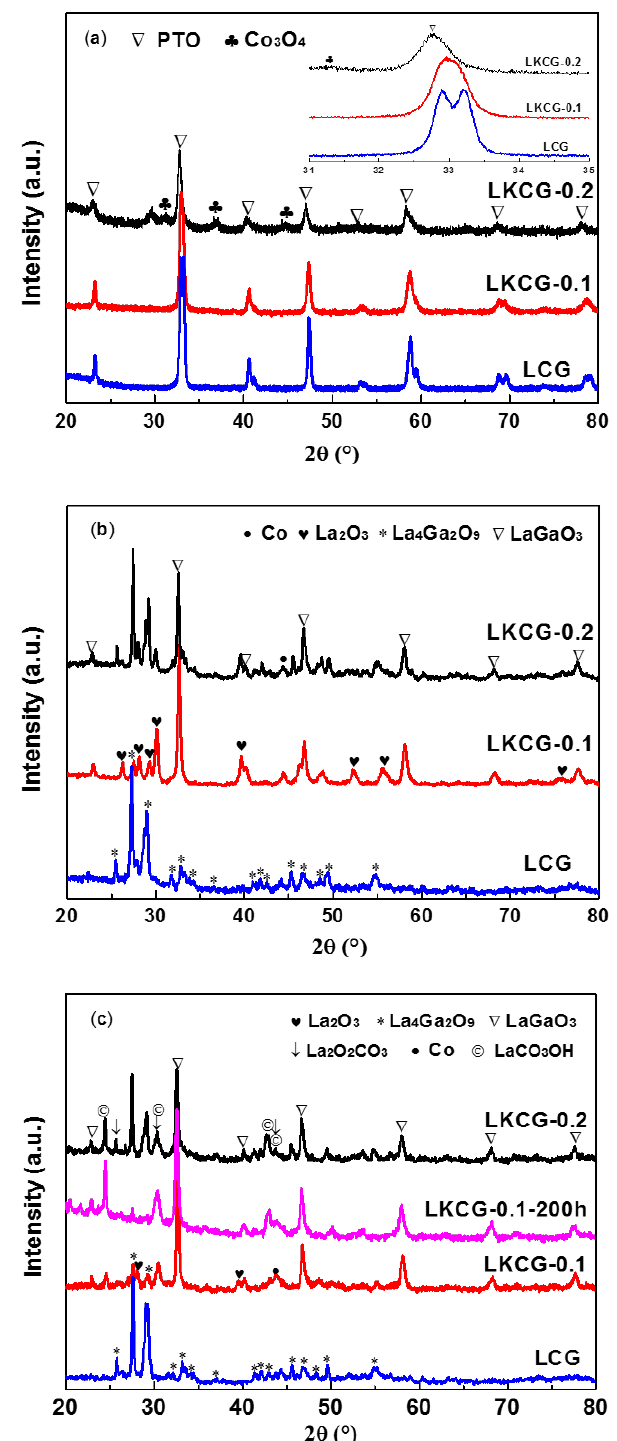
Figure 1. X-ray powder diffraction (XRPD) patterns of catalysts after ( a ) calcination, ( b ) reduction and ( c ) reaction.